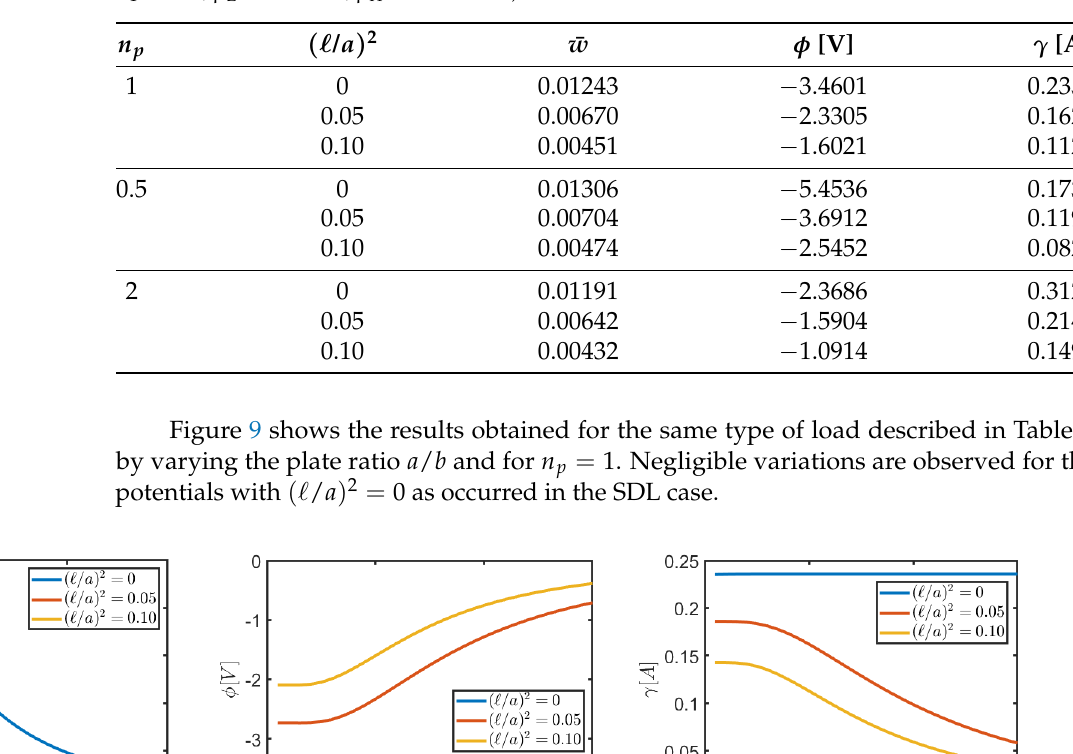
Table 7. Displacement ¯ w , electric and magnetic potential φ and γ , of a square nanoplate at the central point ( a /2, b /2 ) for different values of nonlocal parameter ( (cid:96) / a ) 2 and n p (UDL; q = 0N/m 2 , T 0 = 0,